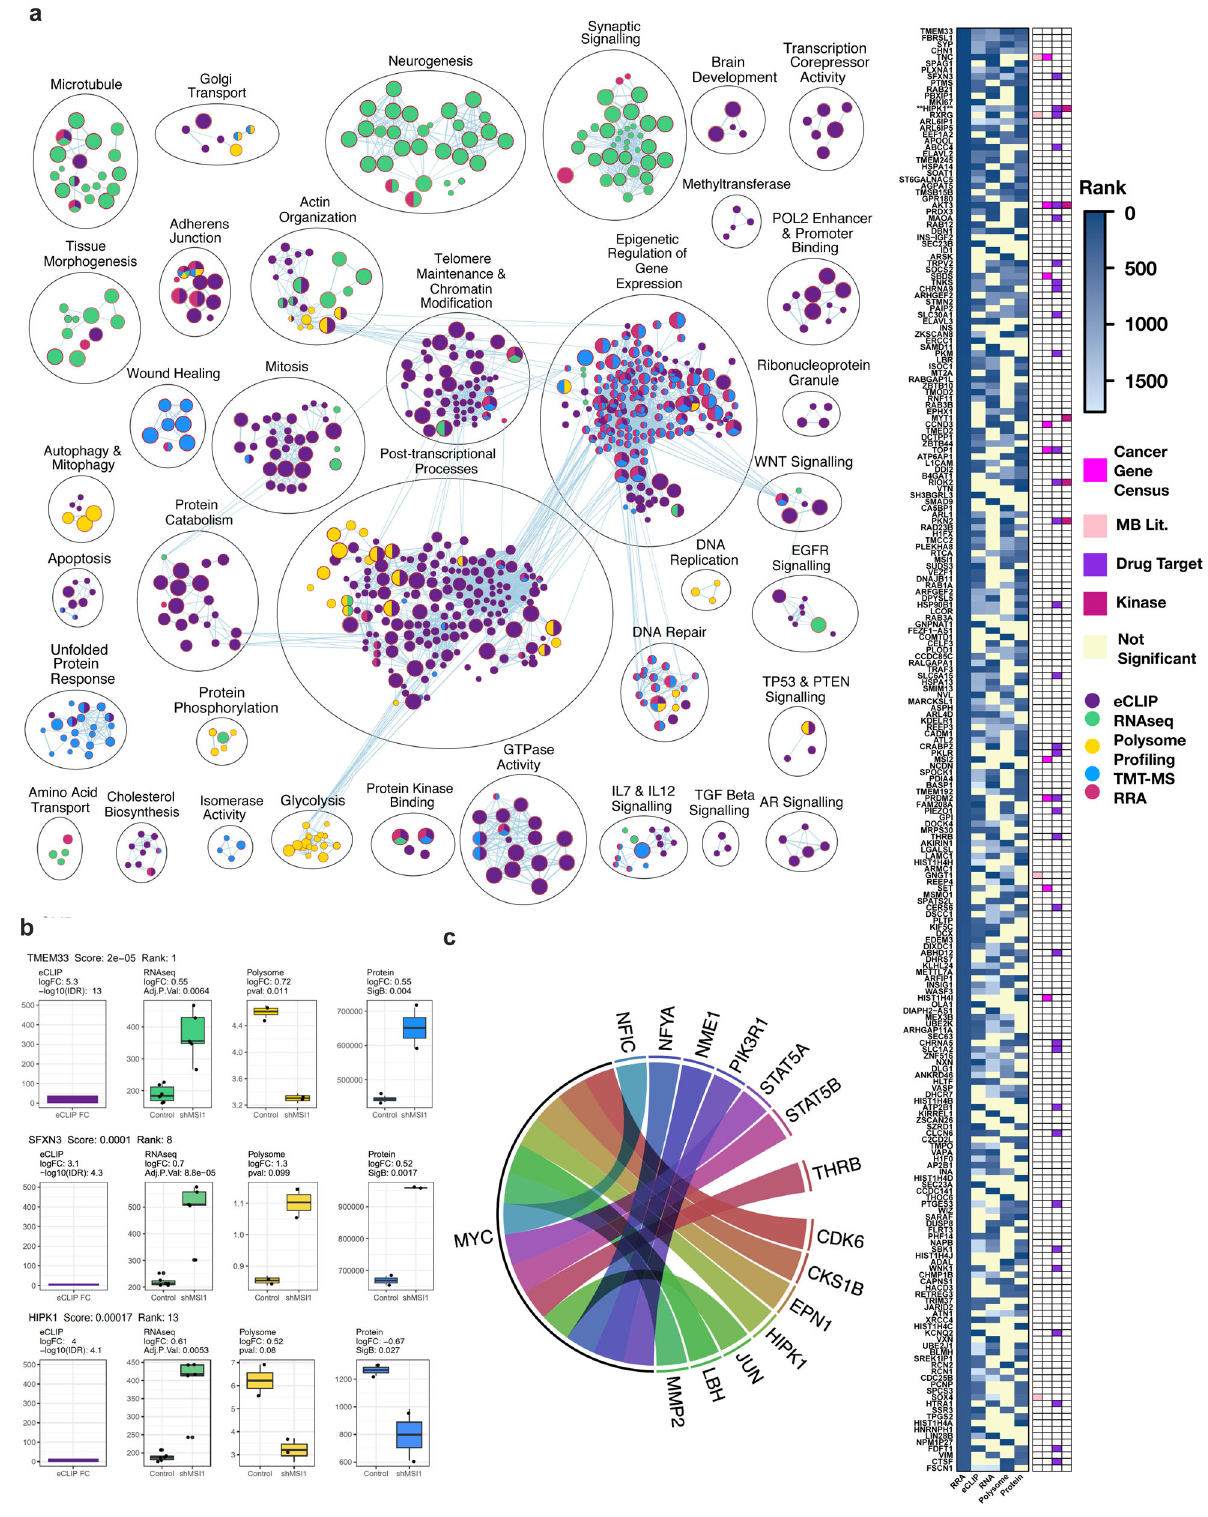
Fig. 4 | Robust ranked analysis (RRA) identi fi es TMEM33, SFNX3 and HIPK1 genesetdirectlyperturbedbyMSI1inG3MB.a Pathwaysanalysisillustratingthe main pathways perturbed by the binding of MSI1 to its target (Purple:eCLIP, Green:RNA-seq,Yellow:polysome-seq,Blue:proteomics(TMT-MS),Pink:RRA).The associated heat map shows the RRA rank and gene association (Yellow denotes